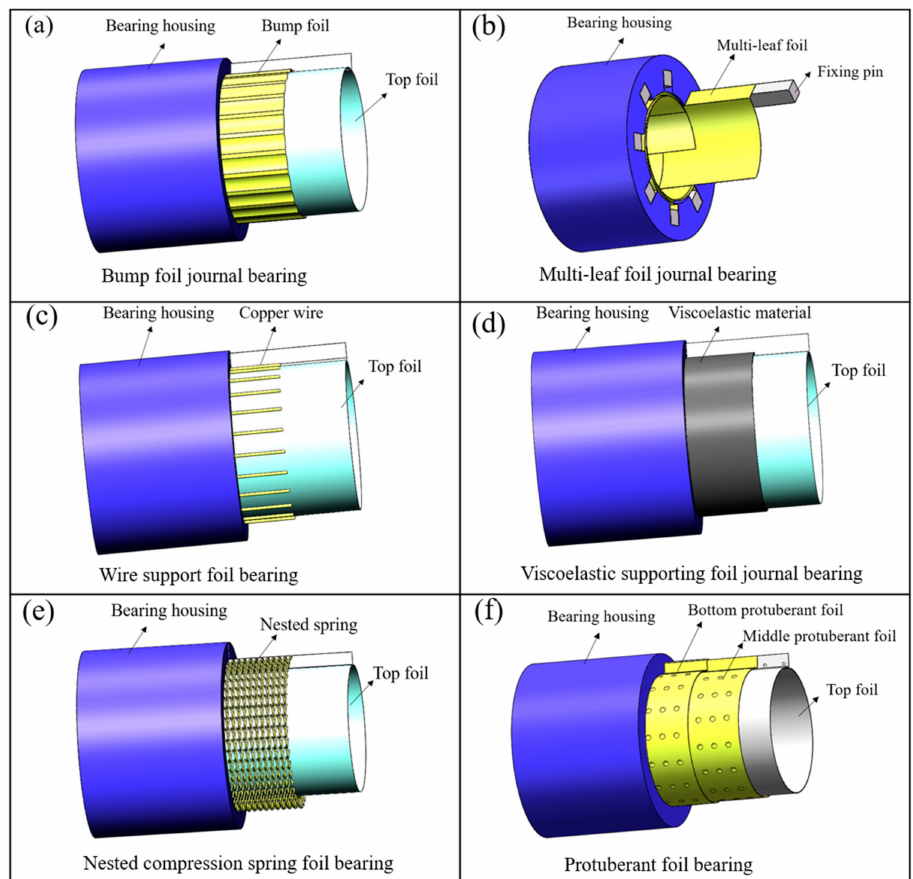
Figure 2. Typical gas foil journal bearings. ( a ) bump foil bearing; ( b ) multi-leaf foil bearing; ( c ) wire supporting foil bearing; ( d ) viscoelastic supporting gas foil bearing; ( e ) spring supported foil bearing; ( f ) protuberant foil